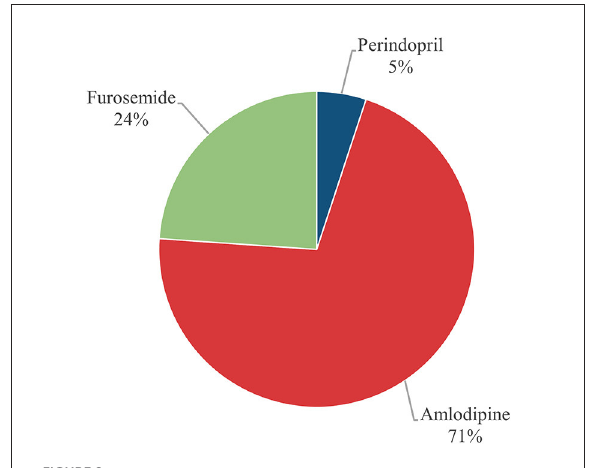
FIGURE2 The proportion of the three antihypertensive